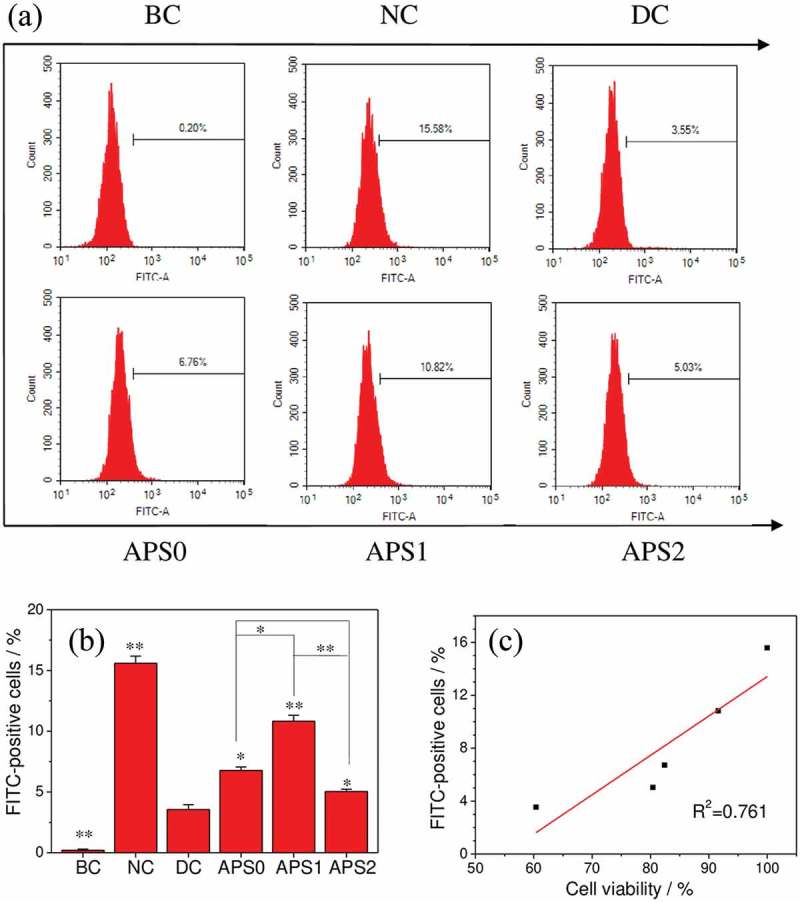
Quantitative detection of endocytotic nano-COD ratio in HK-2 cells before and after APS repair by flow cytometry. (a) Histogram of the proportion of cells with endocytosed COD crystals; (b) statistical histogram of the proportion of cells with fluorescence (i.e. endocytic crystal); (c) the linear relationship between the percentage of endocytosed nano-COD crystals and cell viability. R2 is a linear correlation coefficient. BC: blank control, NC: normal control, DC: damaged control; polysaccharide concentration: 60 μg/mL; oxalate damage concentration: 2.6 mmol/L; damage time: 3.5 h; repair time: 10 h. Compared with DC group, *P < 0.05; **P < 0.01.